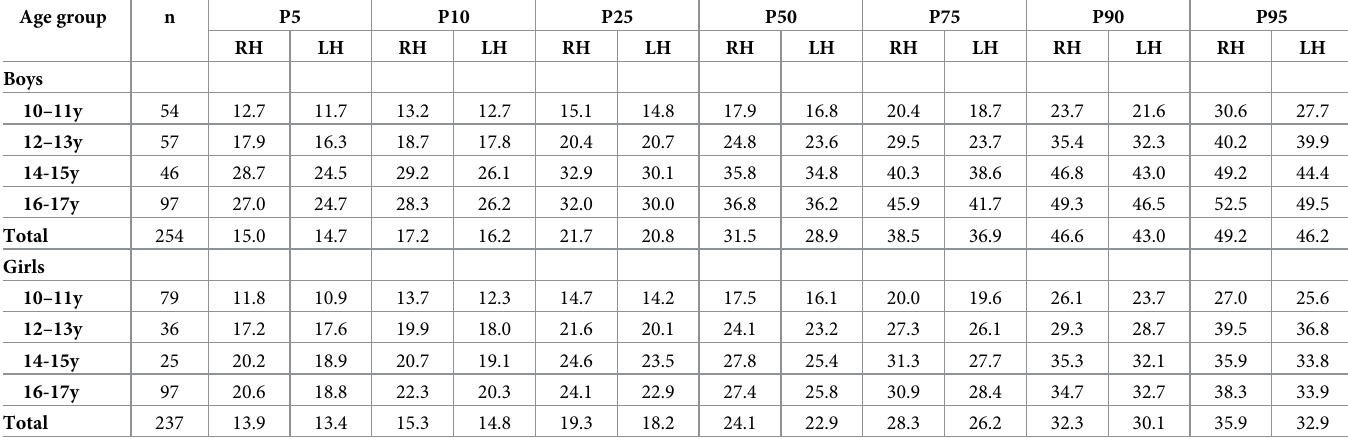
Table 2. Percentile values of maximum strength (kg) of right and left hand by sex and age group in Chilean adolescents.